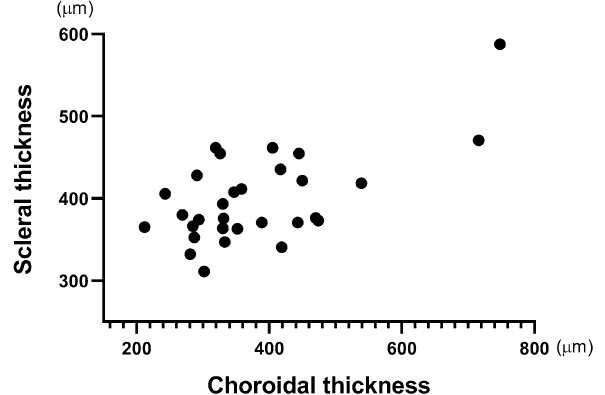
Figure 2. Relationship between choroidal thickness and scleral thickness in all participants.